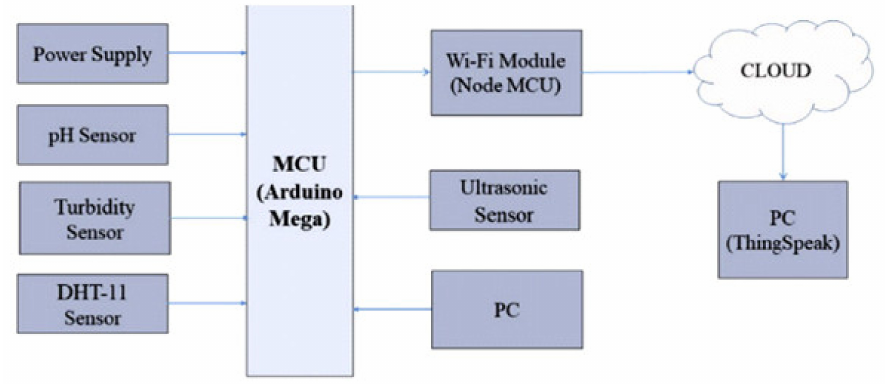
Figure 9. Block diagram of the system proposed in [96].